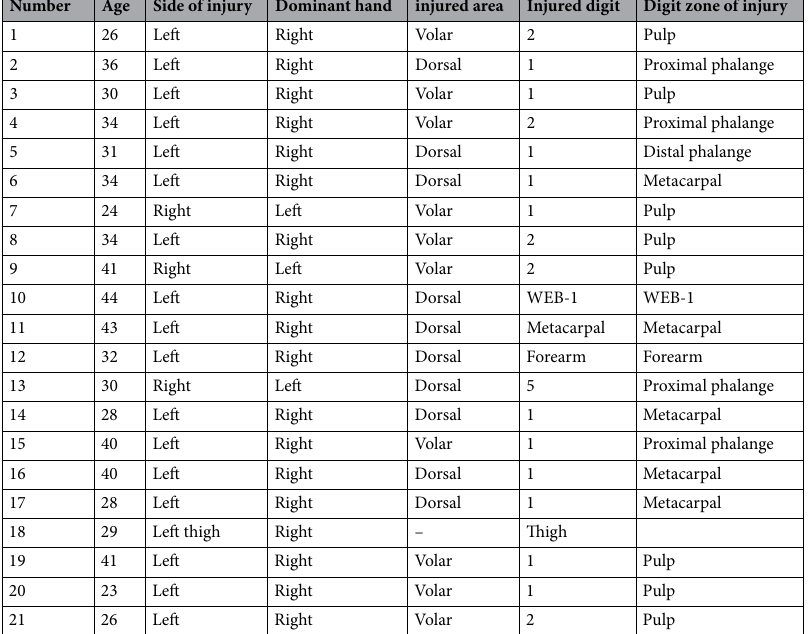
Table 1. Demographics and injury